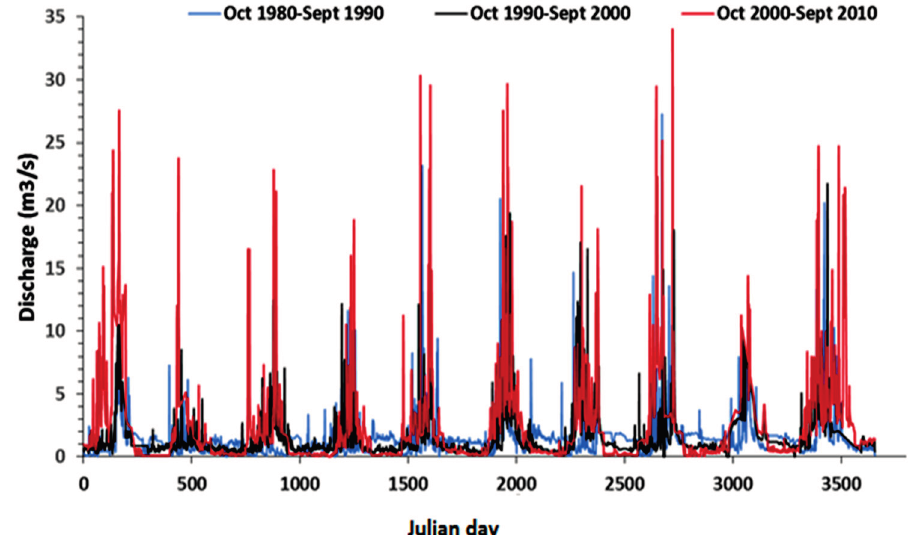
Figure 9. Comparison of streamflow hydrographs in Mukuvisi catchment for the three